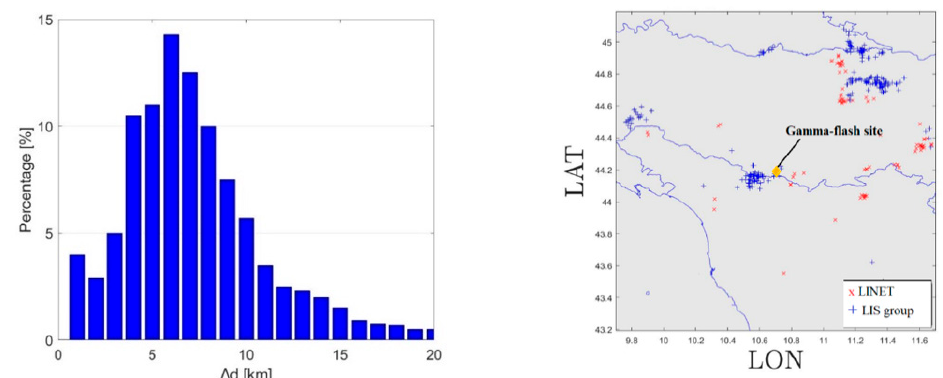
Figure 9. Match Map of coincident LIS and LINET strokes ( left ). Ref. period: 2020. Location difference between matches ( right ) expressed in percentage of occurrence.